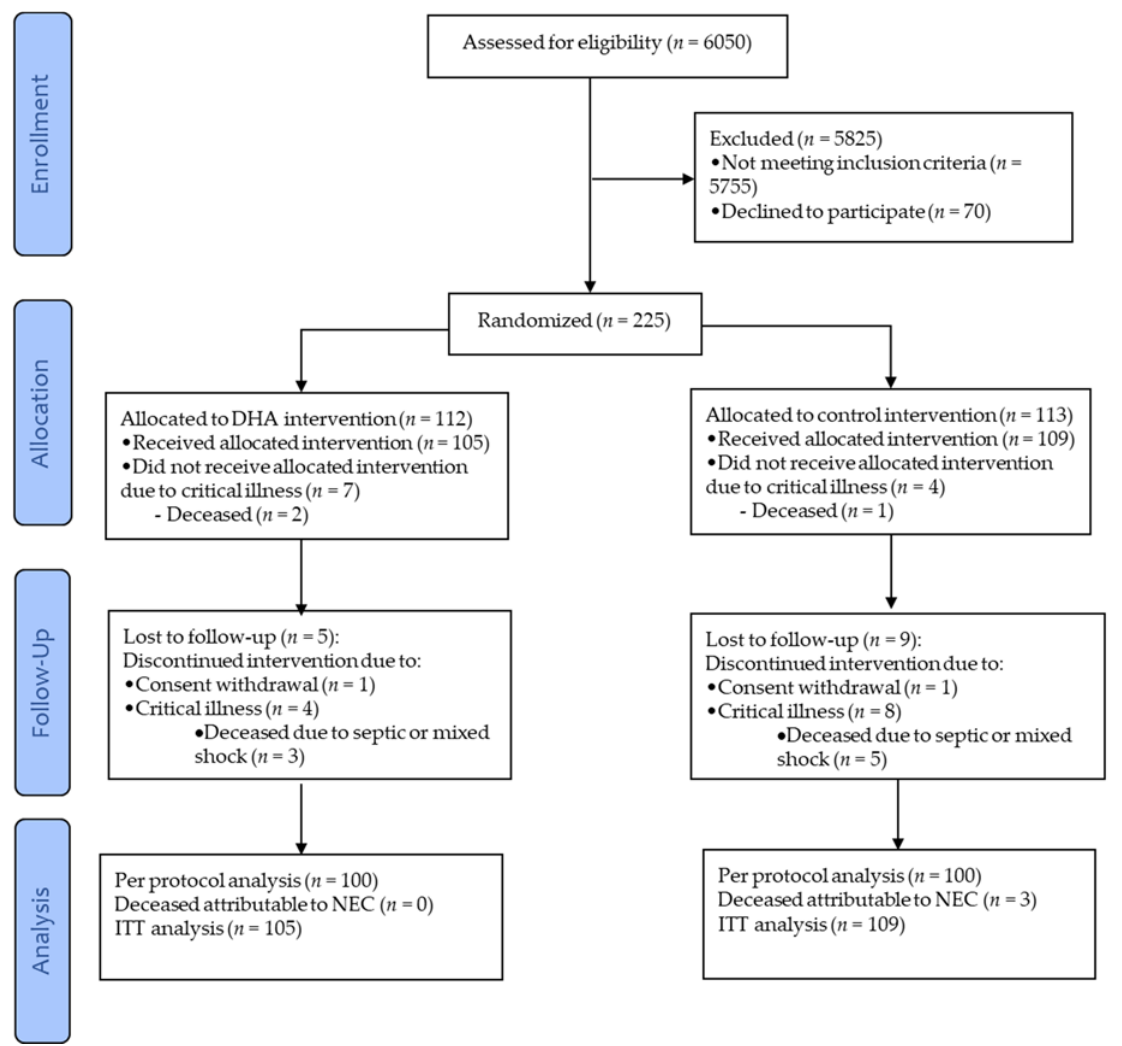
Figure 1. CONSORT diagram depicting the flow of the infants through the study. DHA, docosahexaenoic acid; NEC, necrotizing enterocolitis; and ITT, intent ‐ to ‐ treat. Table 2. Characteristics of the preterm infants.